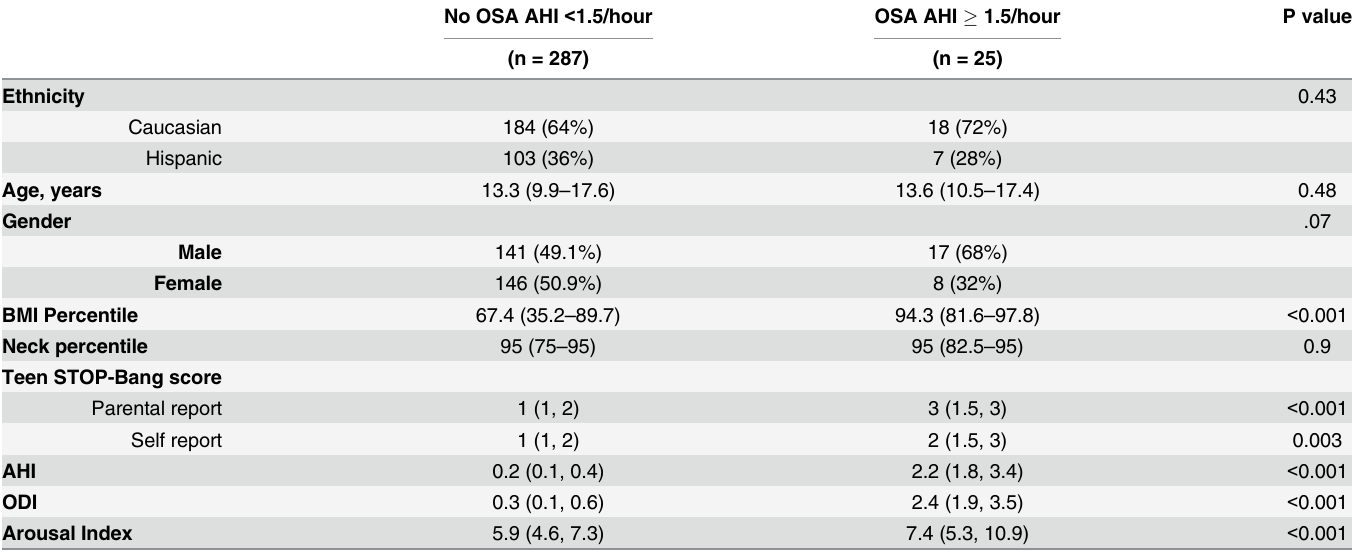
Table 1. Demographics of